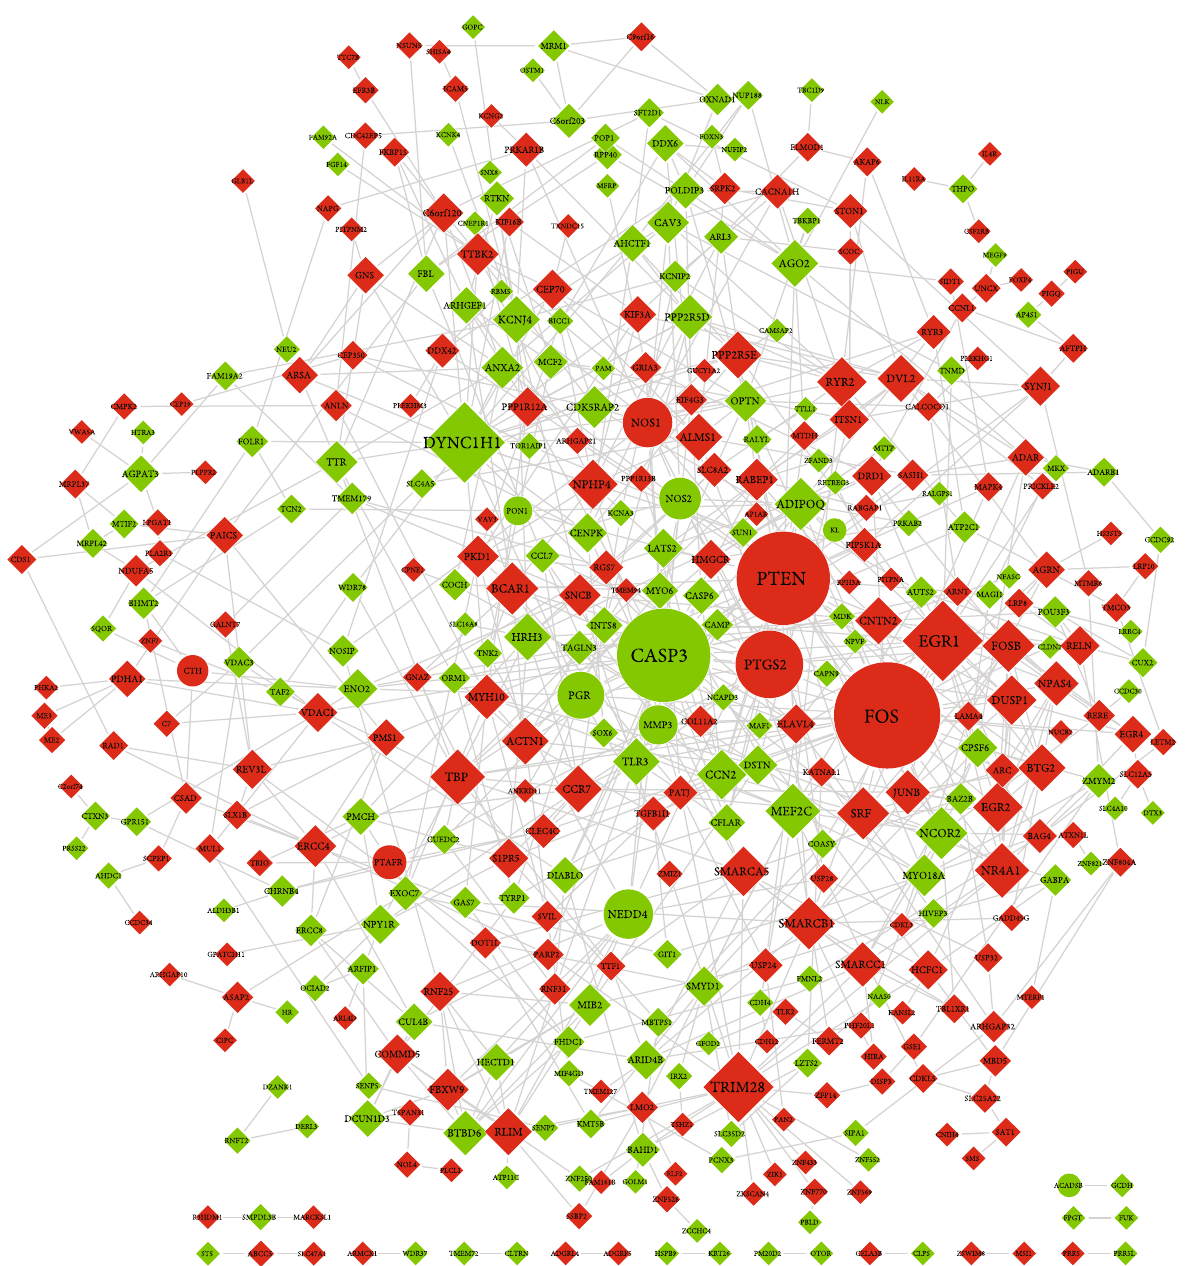
Figure 6: PPI network of identi fi ed genes and other di ff erentially expressed genes from the RNA-seq. Compared with the MG, green shapes represent downregulated mRNAs, and red shapes represent upregulated mRNAs in MGT. Ellipses represent the veri fi ed genes treated by LXTYF for AICH, and diamonds represent other genes di ff erentially expressed. A larger degree of the target nodes with larger